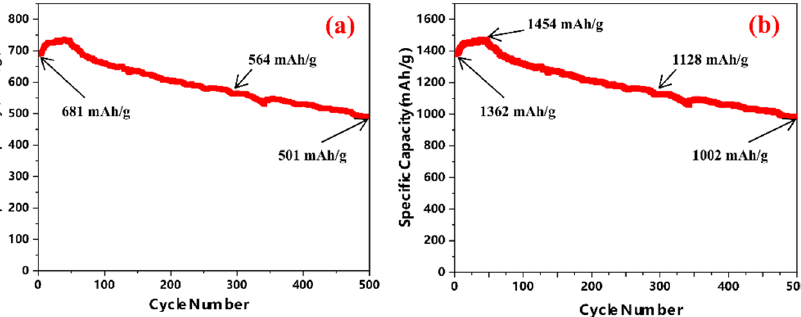
Figure 8. The specific capacity of a Si@void@C half cell as a function of service cycles: ( a ) the specific capacity based on the Si@void@C weight in the electrode and ( b ) the specific capacity based on the Si weight in the electrode. Note that the electrode is composed of 80 wt% Si@void@C, 10 wt% CB and 10 wt% PAA.